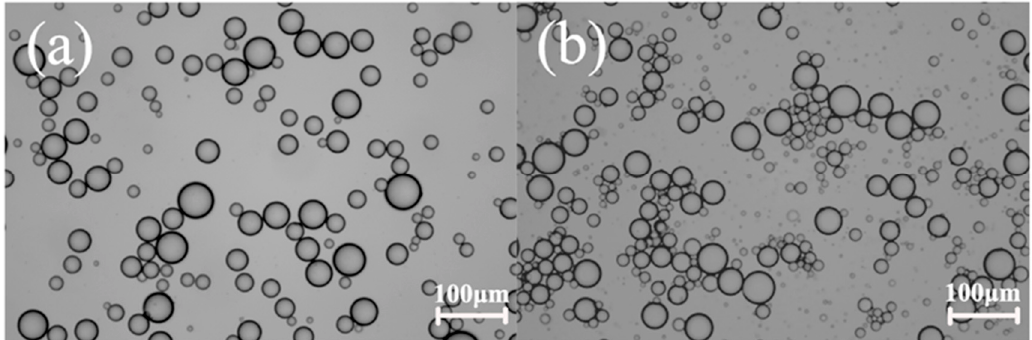
Figure 10. Microscopy images of a Pickering emulsion with droplet size ( a ) 25.43 ± 8.34 μ m and ( b ) 21.97 ± 8.39 μ m before and after redox regulation.